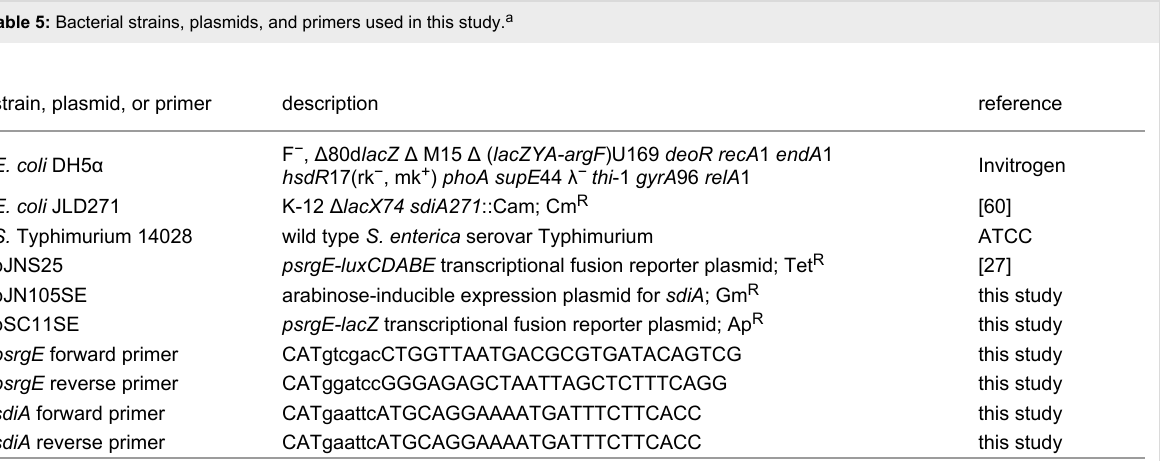
Table 5: Bacterial strains, plasmids, and primers used in this study. a